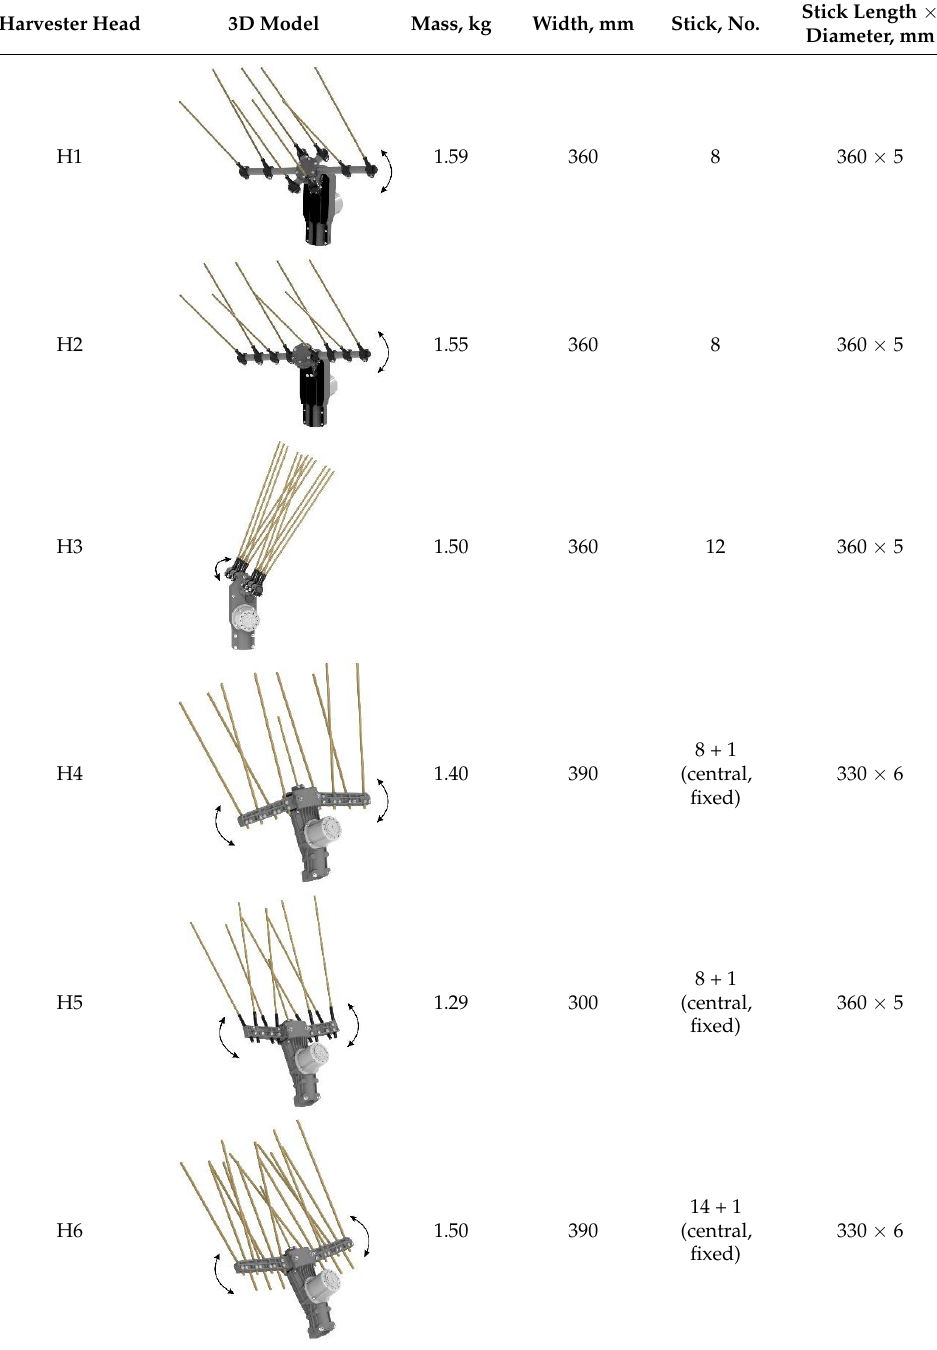
Table 1. Main features of the harvester heads considered in this study.